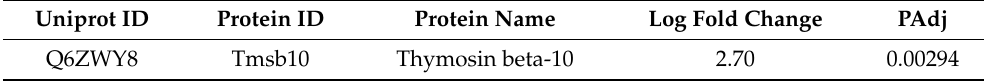
Table 4. List of DEPs between the 8-week (un)treated hippocampal protein datasets.